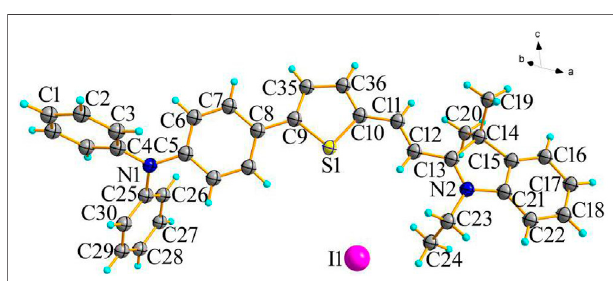
FIGURE 9 | Single crystal X-ray diffraction image of probe